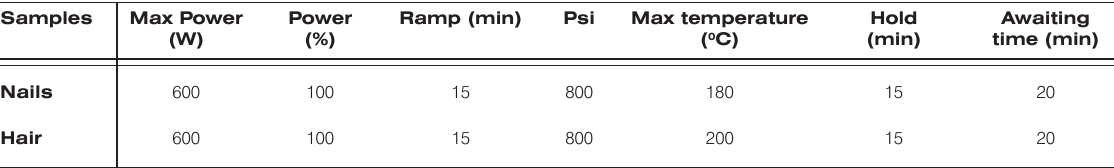
Table 1. Mineralization procedures for hair and nails samples.